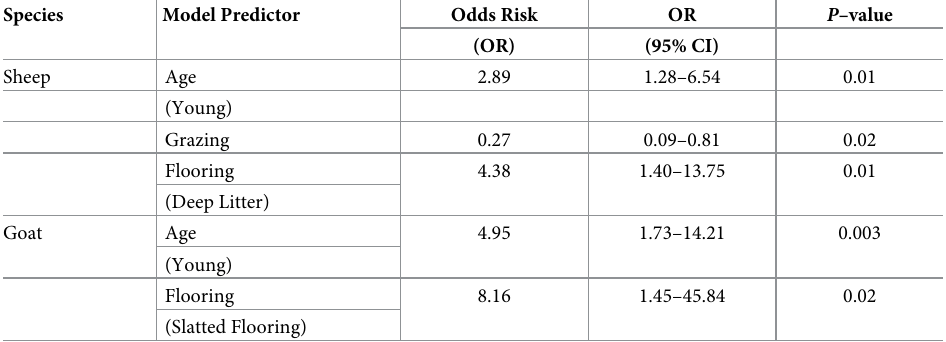
Table 1. Multivariate effects logistic regression model of associations between farm management factors and prevalence of Stx in sheep and goat